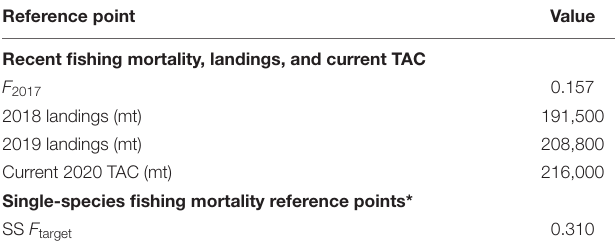
TABLE 2 | Single species and ecological-based reference points (ERP) for Atlantic menhaden. Reference